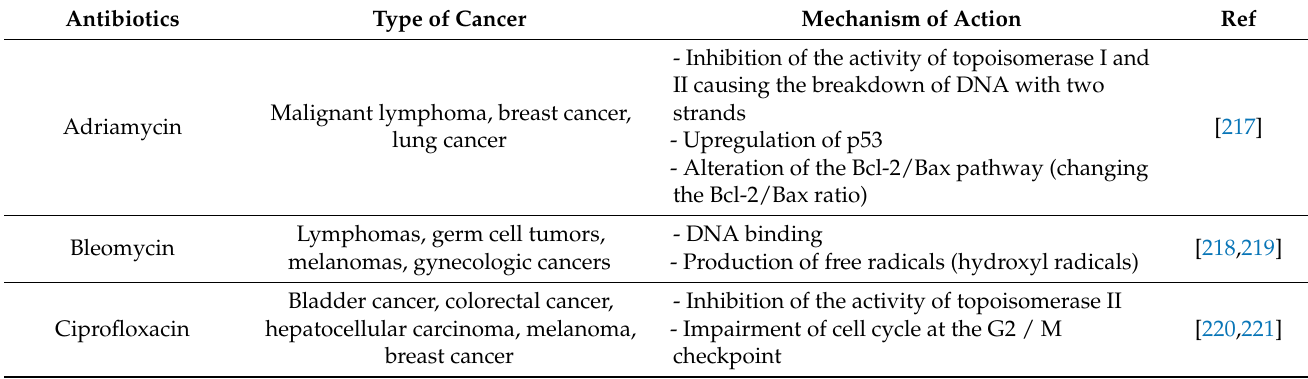
Table 4. Examples of antibiotics with antitumor effect and their known mechanisms of action.